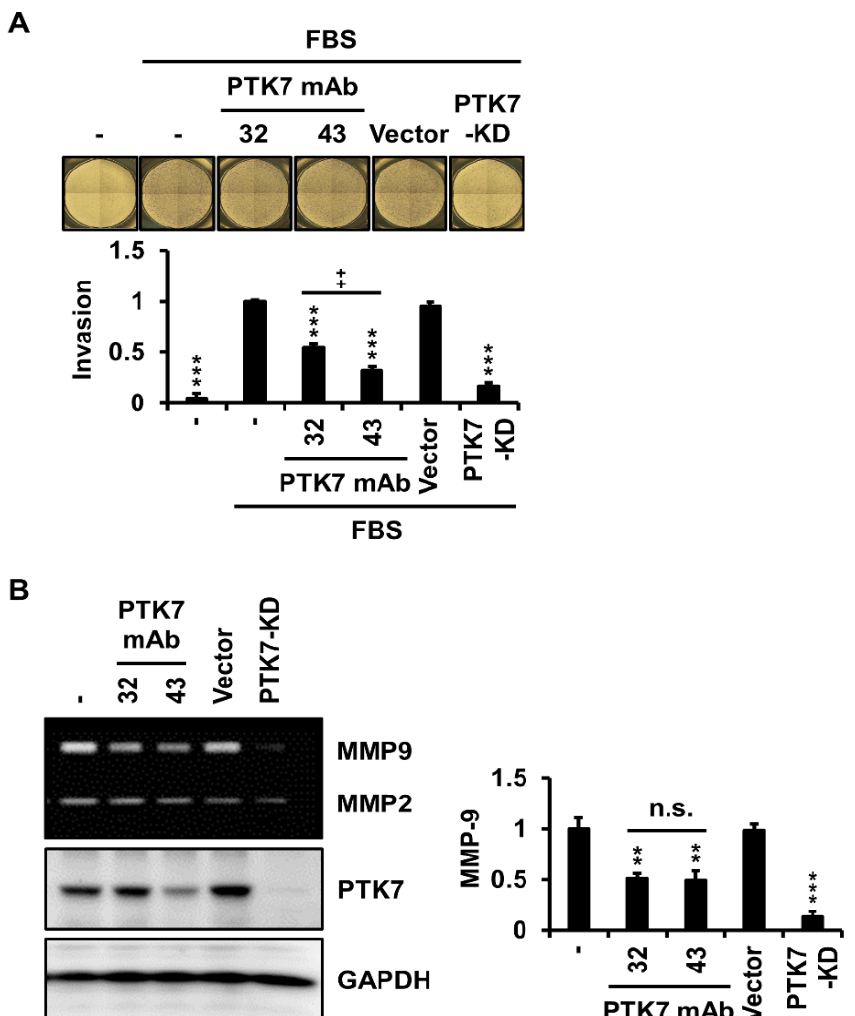
Figure 3. PTK7 mAbs reduce cell invasion and MMP-9 secretion in KYSE-30 cells. KYSE-30 cells infected with the vector or PTK7 knockdown viruses were used as controls. ( A ) Chemotactic invasion was analyzed after incubation of KYSE-30 cells in DMEM/F12 medium with or without 2% FBS in the presence of PTK7 mAb (10 µ g/mL) for 48 h using a Transwell plate. The invaded cells were stained with crystal violet. Representative micrographs (x40) are shown. Quantification of the invasion assay is described in the Materials and Methods section. Each bar represents the mean ± SD of three independent experiments: *** p < 0.001 vs. cells treated with FBS alone; ++ p < 0.01 between PTK7 mAb-32 and PTK7 mAb-43. ( B ) MMP-2 and MMP-9 levels in the conditioned medium of KYSE-30 cells, which were incubated in serum-free DMEM/F12 medium with or without PTK7 mAbs (10 µ g/mL) in the presence of TNF- α (1 ng/mL) for 24 h, were analyzed using gelatin zymography. Protein levels in zymograms were quantitated using ImageJ software (version 1.52). Each bar represents the mean ± SD of three independent experiments: ** p < 0.01 or *** p < 0.001 vs. cells treated with TNF- α alone; n.s. (not significant) between PTK7 mAb-32 and PTK7